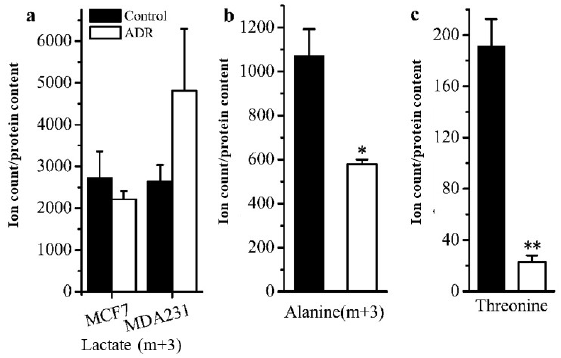
Figure 3. Comparison of cell metabolism between the ADR-treated senescent and non-treated cancer cells measured by isotope tracing analysis: ( a ) levels of the m + 3 isotopologue of lactate in MCF7 and MDA-MB-231; ( b ) levels of the m + 3 isotopologue of alanine in MCF7. ( c ) Measure of threonine levels in MCF7. * signifies p < 0.05 and ** signifies p < 0.005.